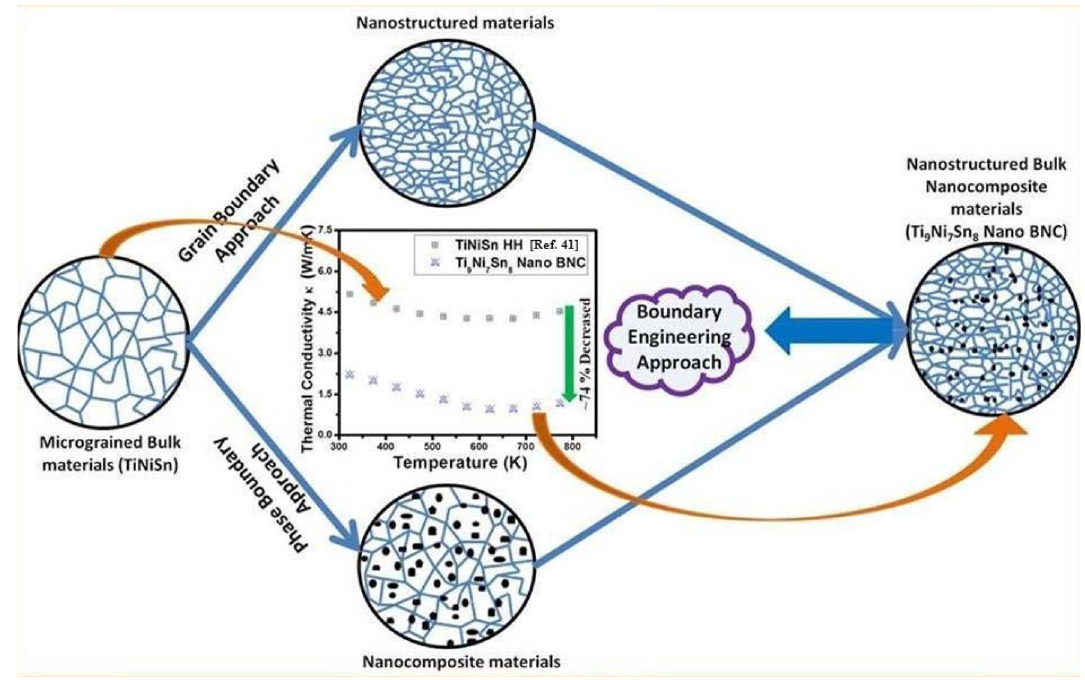
Fig. 6 Strategies for reduction in thermal conductivity via using boundary-engineered approach on TiNiSn-based HH materials starting from micrograined bulk TiNiSn to form phase and grain boundary modified nanostructured BNC Ti 9 Ni 7 Sn